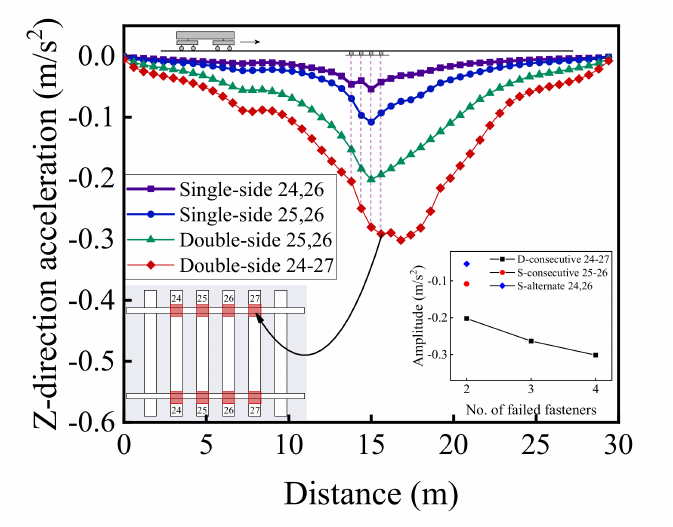
Figure 30. The longitudinal variation of vertical acceleration response of subgrade surface layer under the left rail with different patterns of rail fastener